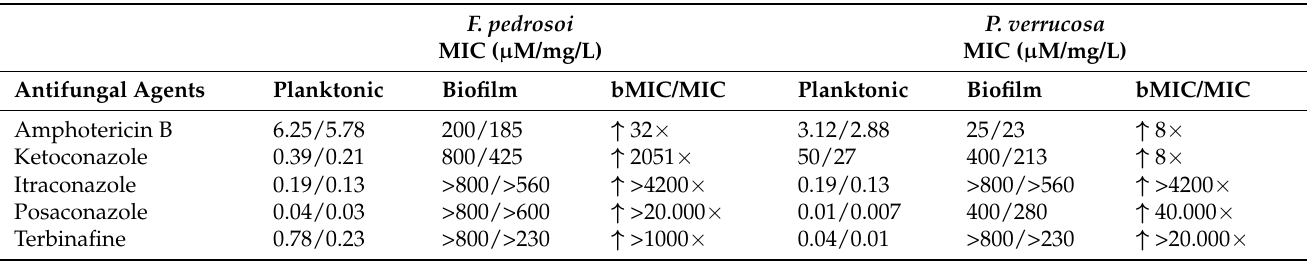
Table 1. The susceptibility of planktonic- and biofilm-forming cells of F. pedrosoi and P. verrucosa to antifungal